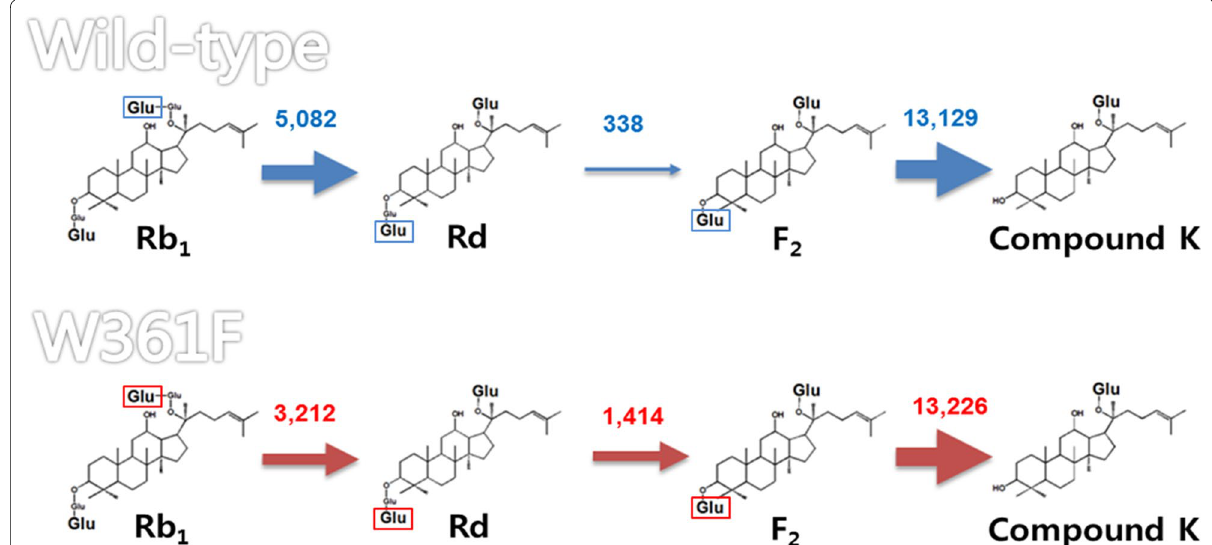
Fig. 5 Hydrolytic pathways from ginsenoside Rb 1 to compound K by the wild‑type and W361F variant enzymes. Numbers indicate the specific activity (nmol min − 1 mg − 1 ) for the substrates at each step. The thickness of arrow is depicted in proportion to the specific